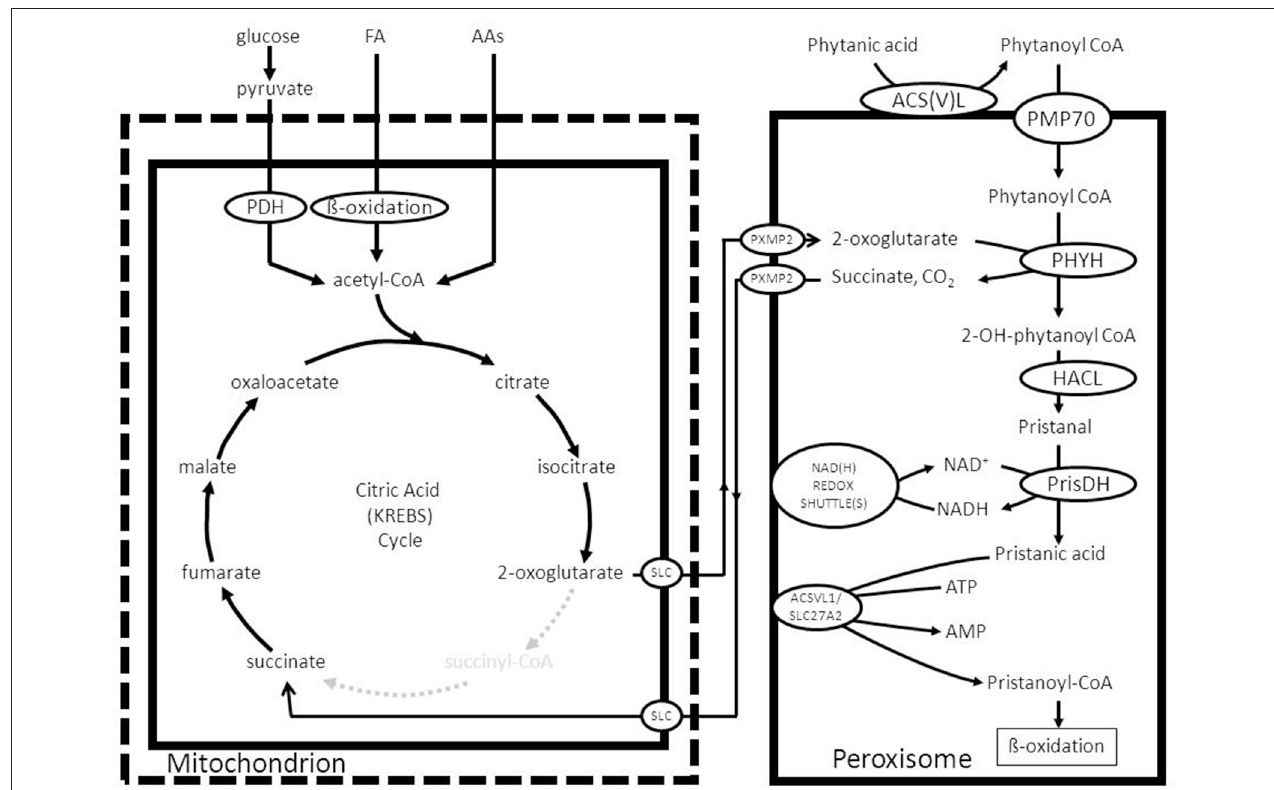
FIGURE 9 | Functional interplay between mitochondria and peroxisomes in the alpha-oxidation of phytanic acid. See text for detailed